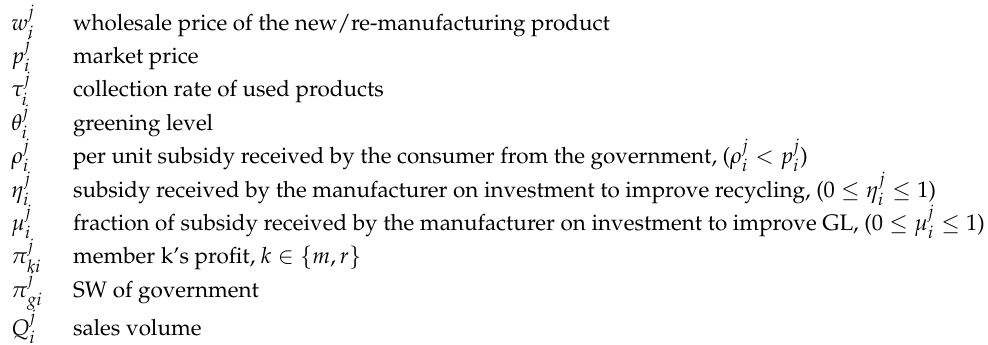
Table 2. Decision and auxiliary